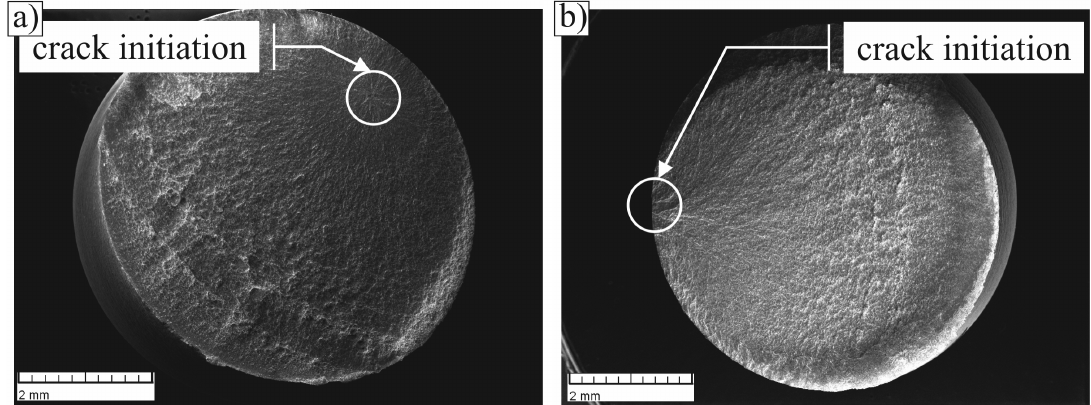
Figure 13. Fracture surfaces of specimens deep rolled at cryogenic temperature after fatigue tests applying a cyclic loading amplitude of 460MPa. The overview SEM micrographs depict the respective crack initiation points. The specimens are characterized by fundamentally different fatigue lives, i.e., 500,000 cycles ( a ) and 25,000 cycles ( b